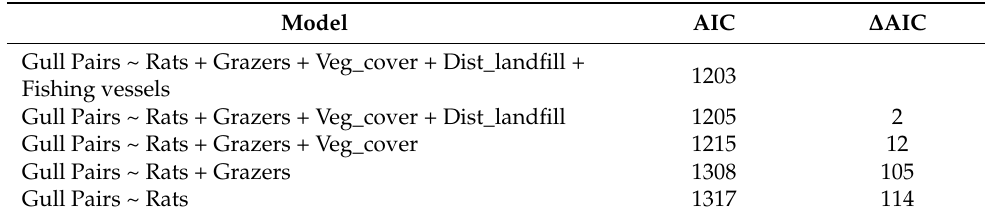
Table 1. AIC and ∆ AIC values for islet-level models tested.